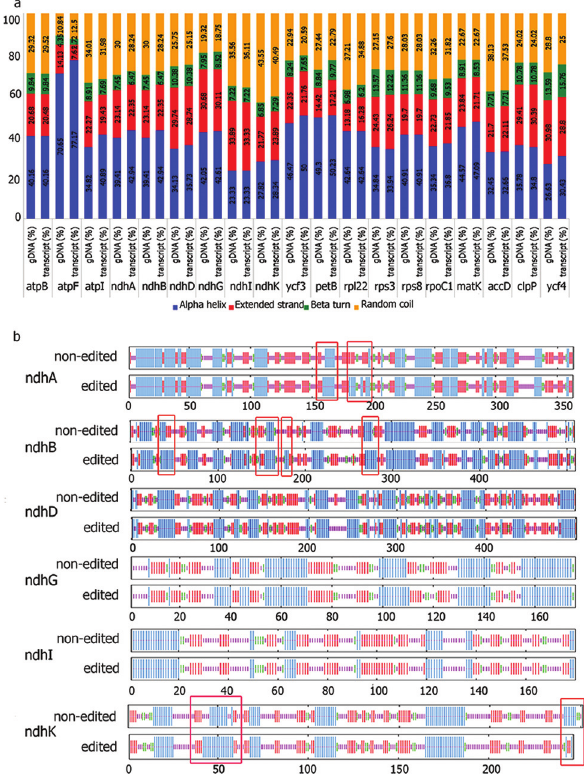
Figure 2 - Comparison of protein structure before and after editing. (a) The proportion of protein secondary structures (in percentages) derived fromgDNAsequenceandtranscriptsequences.Blue:alpha-helix,red:ex- tended strand, green: beta-turn, orange: random coil. (b) Patterns of transmembrane regions in NDH proteins compared between non-edited and edited sequences. Squares indicate altered transmembrane regions.